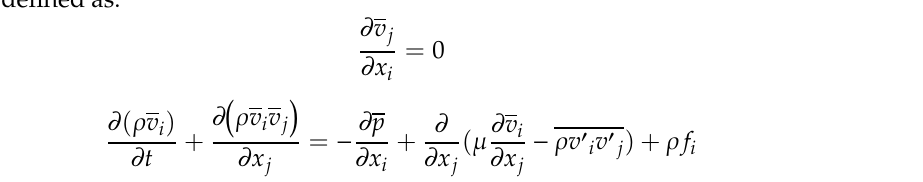
Figure 5. Optimization flow chart in the ANSYS Workbench. 3.1. Optimization Functions According to engineering requirements, the forward design flow rate was chosen as 0.36 m 3 /s and the reverse design flow rate was chosen as 0.3 m 3 /s. The optimization objectives can be described as follow: